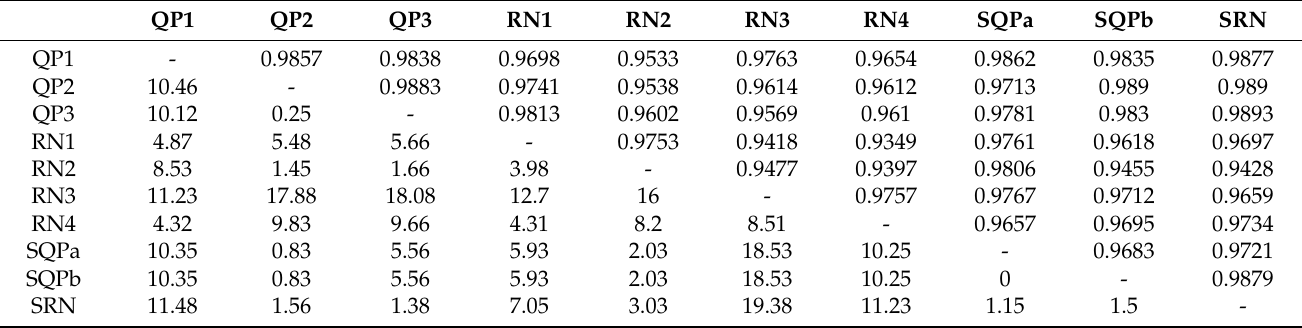
Figure 1. Localization of the sites where the inventory of the Macroheterocera fauna was carried out in the Narew National Park (NNP), Podlaskie Voivodeship, North-East Poland. Table 1. Distances between the studied forest sites in the NNP, Podlaskie, North-East Poland (kilometers) are present in the down triangle and the Morisita similarity values of the distribution of the number species among sites based on the species larval food necessities in the upper